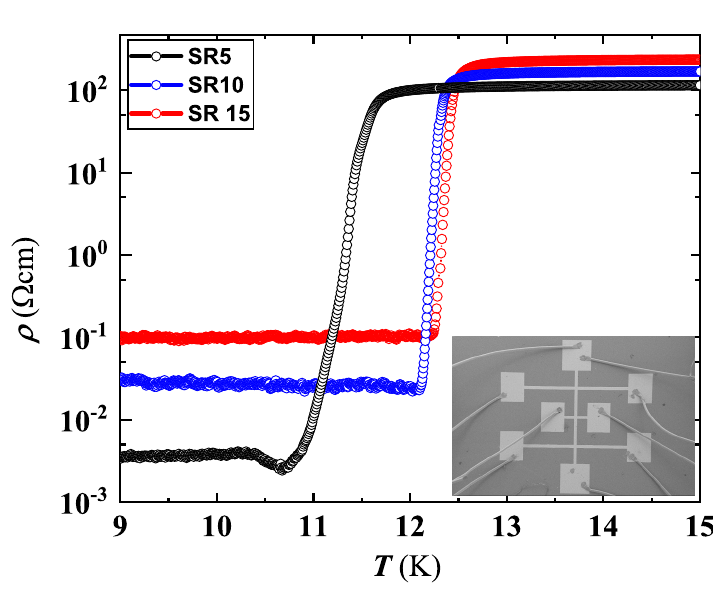
Figure 1. NbN resistivity behavior around T c , for the set deposited on the Al 2 O 3 r − cut substrate (see Table 1). Inset: Scanning electron microscopy of a typical Hall bar shaped film with Al wires bonded to sample pads. Current carrying contacts were located on the top and bottom, along the vertical line; and a couple of lateral contacts from the same side were used to detect the voltage